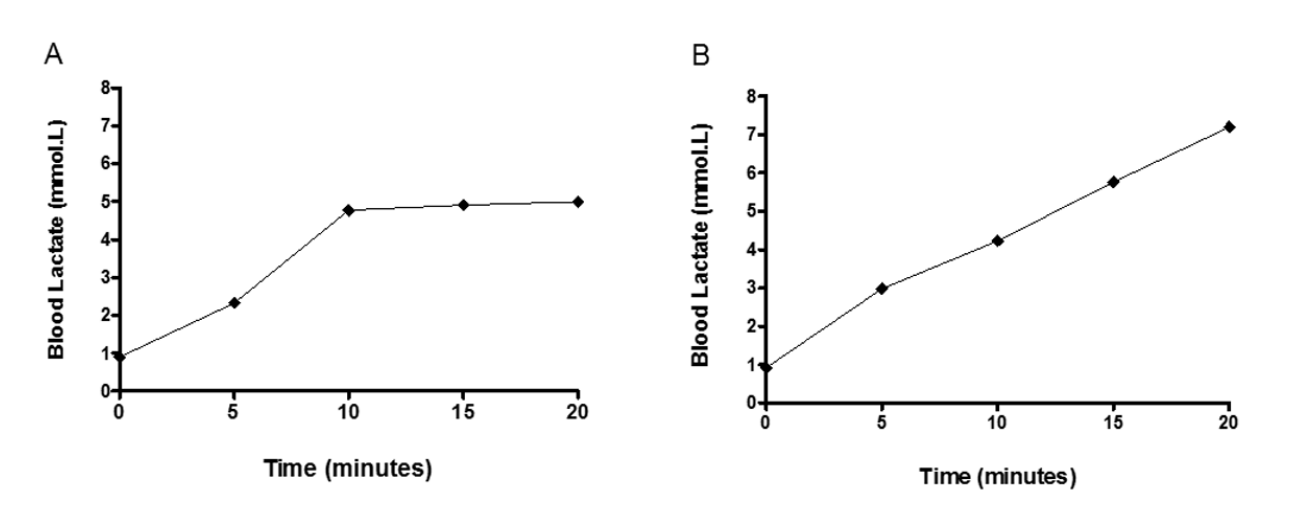
Figure 2. Blood lactate concentration vs exercise time of one rat (same as rat in Figure 1) during constant load test bore load (individual) at LMI (A) and; carrying out constant load above LMI obtained by LACmin